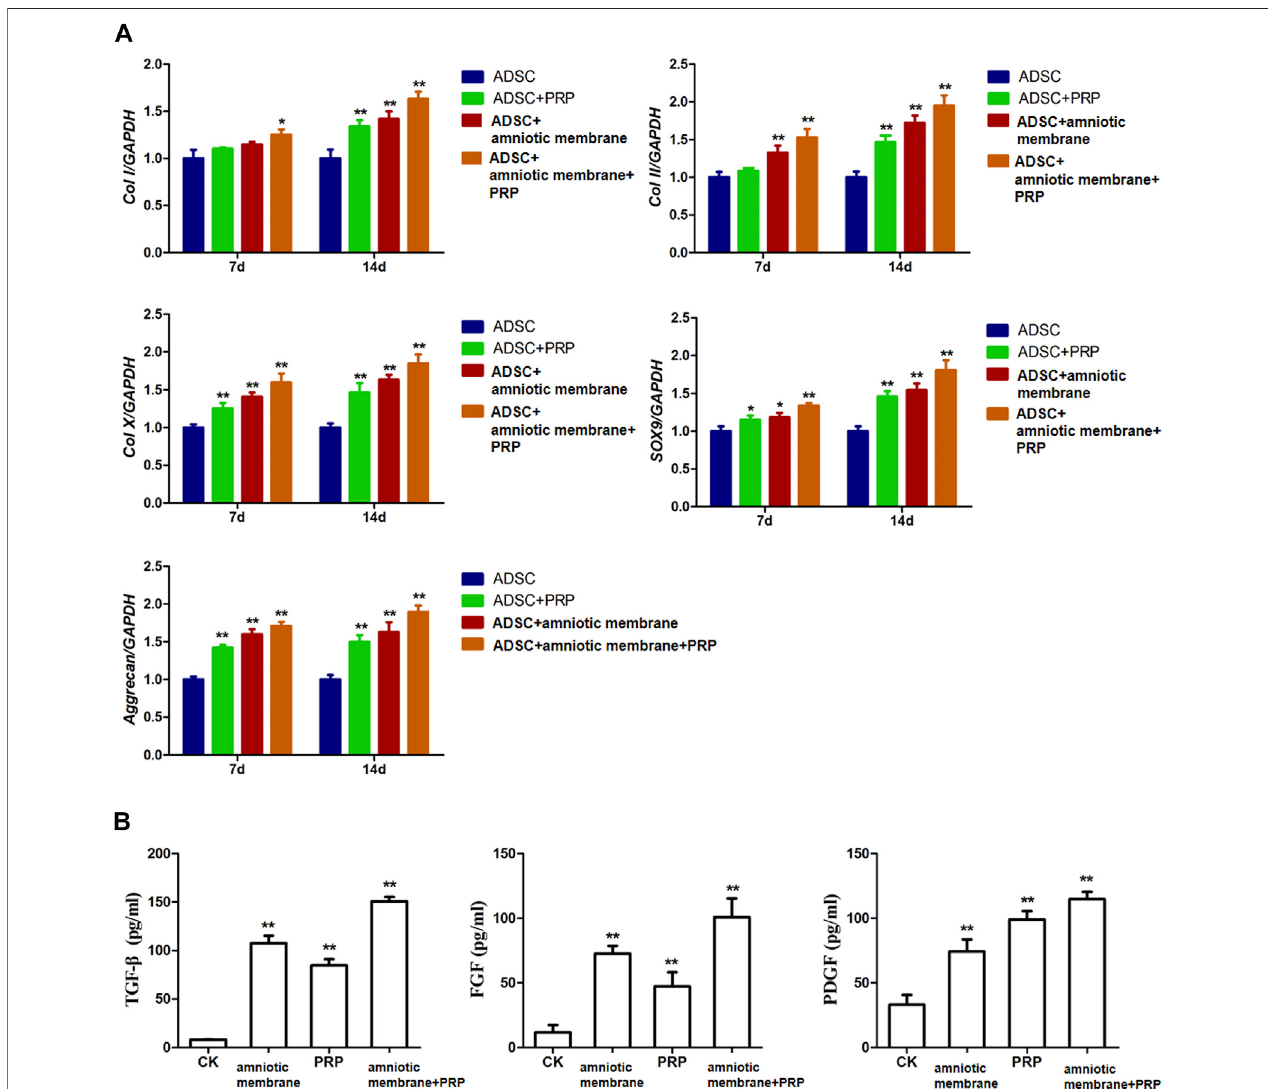
membrane + PRP group. The expression of various factors in each group was detected at 7 and 14 days after the same culture conditions. (A) RT-PCR was used to detectthemRNAexpressionofcollagenI/II/X,SOX-9,andaggrecan.Onday7andday14,themRNAtranscriptionlevelsofColI,ColII,Colx,SOX9,andAggrecan genes were ADSC + amniotic membrane + PRP group > ADSC + amniotic membrane group > ADSC + PRP group > ADSC group. At the 14th day, the transcription levelsofthesegenesinthefourgroupsweresigni fi cantlyhigherthanthoseonthe7thday.* p < 0.05, **p < 0.01.Fivebiologicalrepeatswereincludedineverygroup.CK: ADSCalone, n (cid:2) 5;PRP:PRP+ADSC, n (cid:2) 5;amnioticmembrane:amnioticmembrane+ADSC, n (cid:2) 5;PRP+amnioticmembrane:ADSC+PRP+amnioticmembrane, n (cid:2) 5. (B) The expressions of TGF- β , PDGF and growth factor FGF in ADSC cultured on day 14 were detected by ELISA. The expression levels of TGF- β and FGF